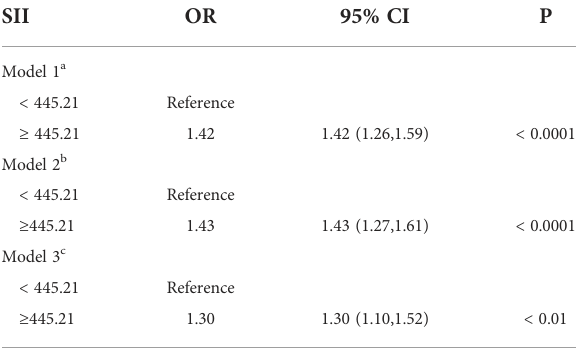
TABLE 2 Association Between SII and hepatic